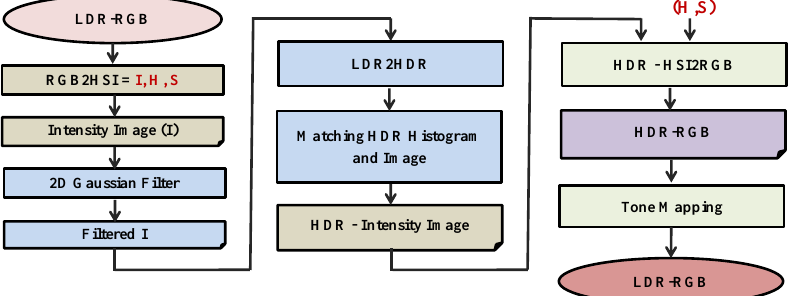
Figure 2. The framework of the proposed LDR2HDR system. The first module is the pre-processing of the intensity image. The second module is to extend the LDR to HDR intensity histogram and match it with the original intensity image to obtain an HDR intensity image. The final module is used to convert the HSI to RGB color spaces for the HDR image, where (H, S) stands for hue and